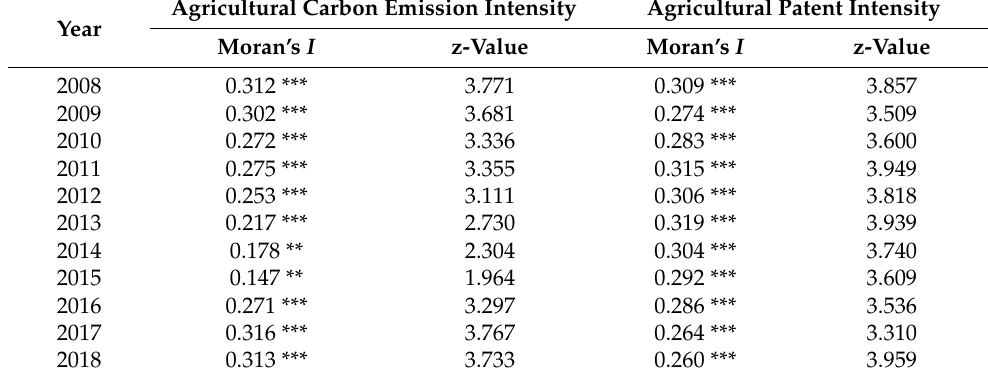
Table 4. Global Moran’s I index.